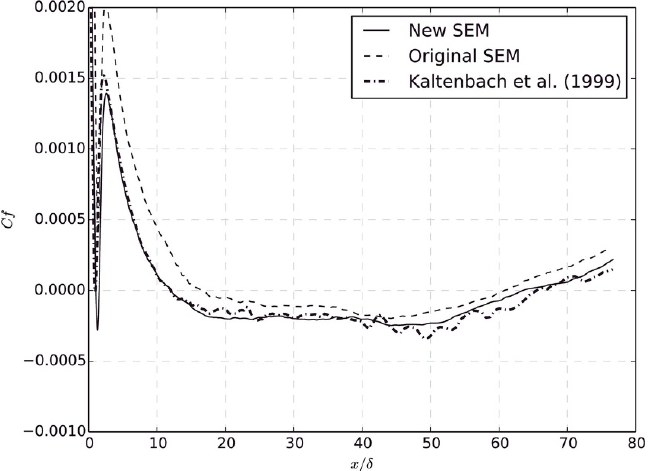
Figure 5. Wall shear stress for the inclined wall ( Cf : wall shear stress, x / δ : normalized distance from the start of the incline)